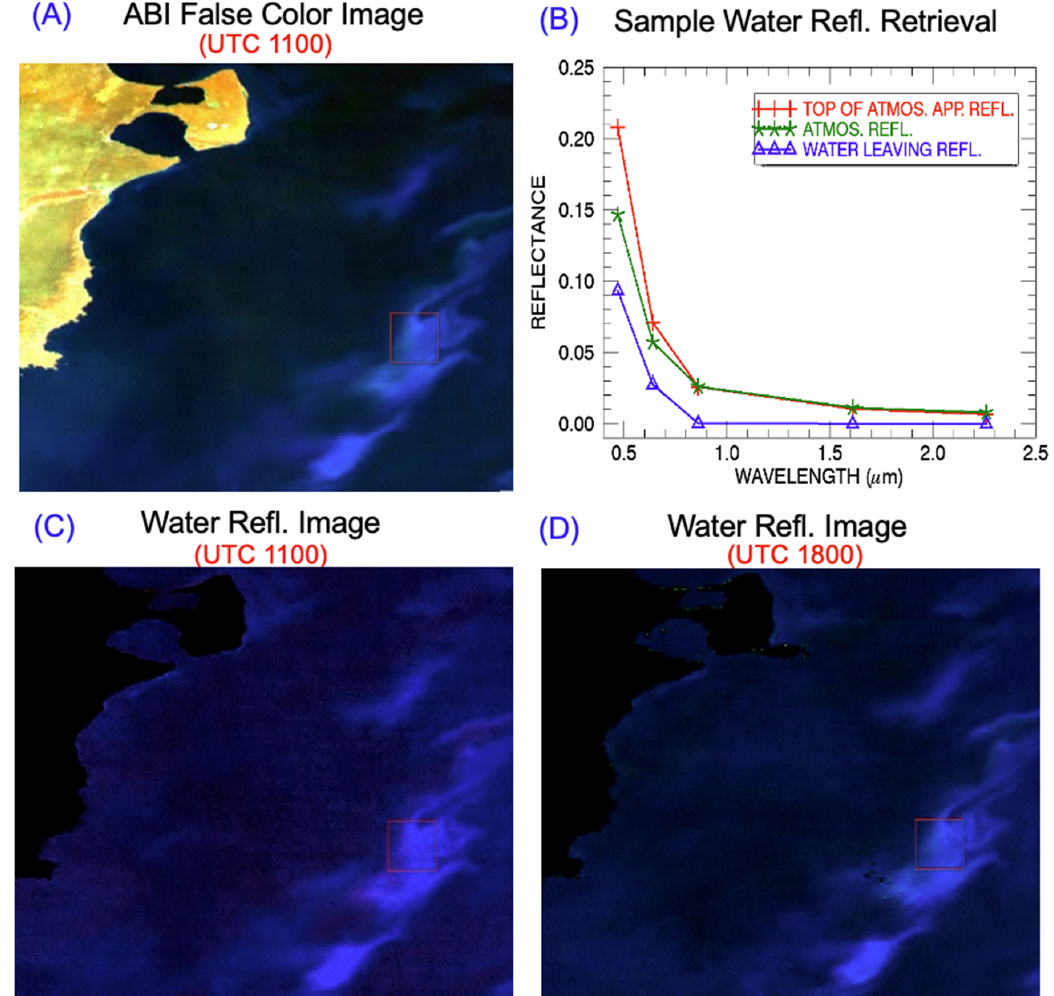
Figure 4. ( A ) — a false color ABI image acquired at UTC 1100 on December 17, 2018 off the coast of Argentina covering algae blooming regions; ( B ) — spectral plot for a bright pixel for top of atmosphere (TOA) apparent reflectances (red line), atmospheric reflectances (green line), and water leaving reflectances (blue line); ( C ) — the retrieved false color water leaving reflectance image for the UTC 1100 scene; and ( D ) — the derived false color water leaving reflectance image for the UTC 1800 scene. Based on our experience in developing MODIS and VIIRS versions of atmospheric correction